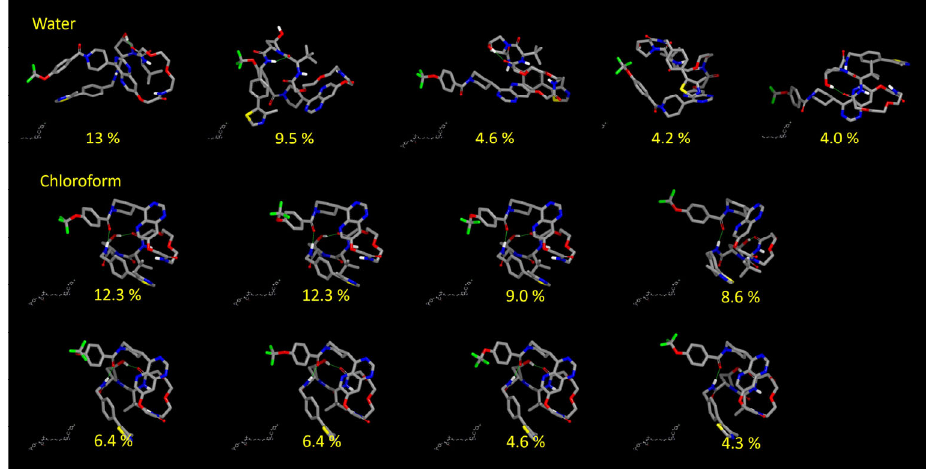
Figure 6. Most relevant conformations, probability greater than 4%.